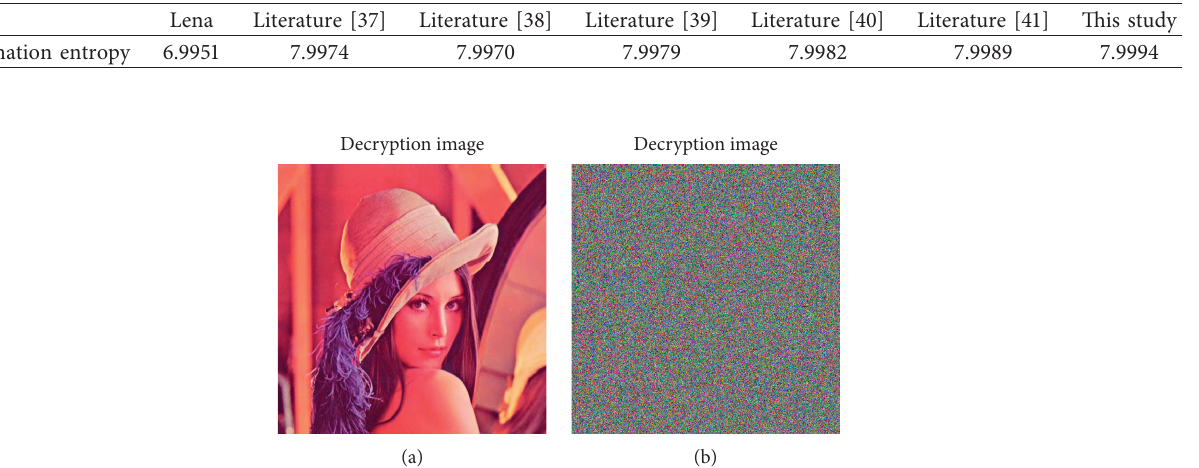
Table 6: Information entropy comparison.